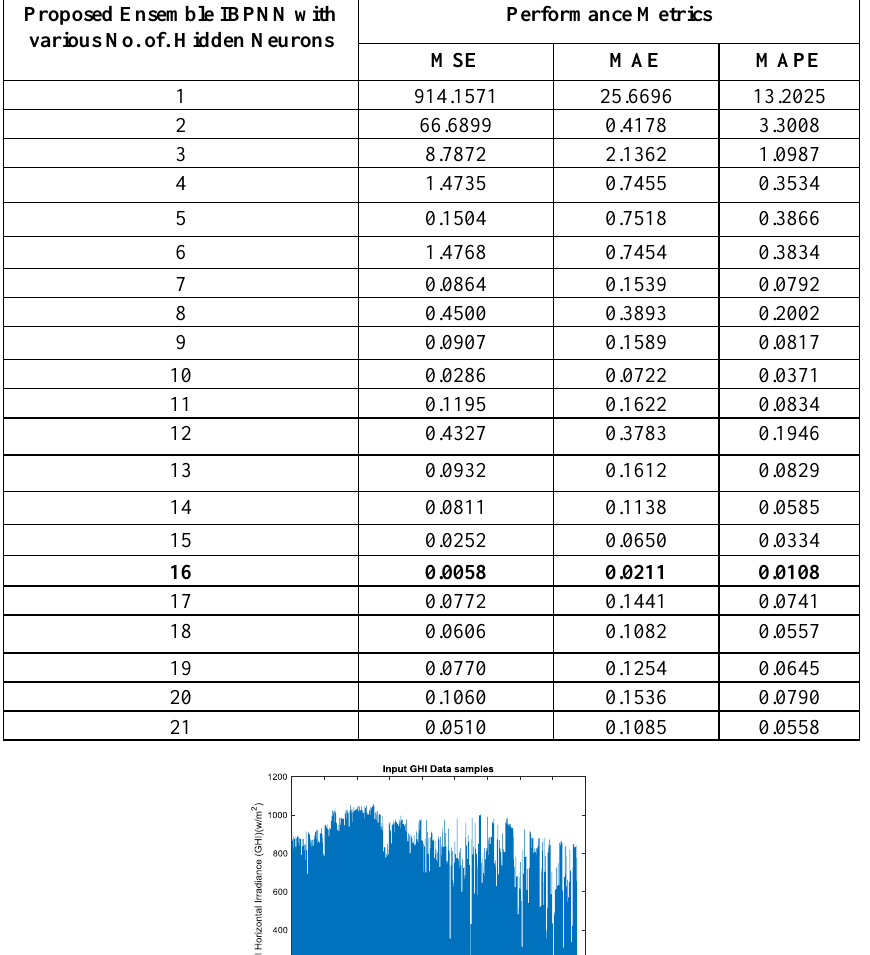
Table 2. Sensitive analysis of the proposed EIBPNN with various hidden neurons. Proposed Ensemble IBPNN with various No. of. Hidden Neurons